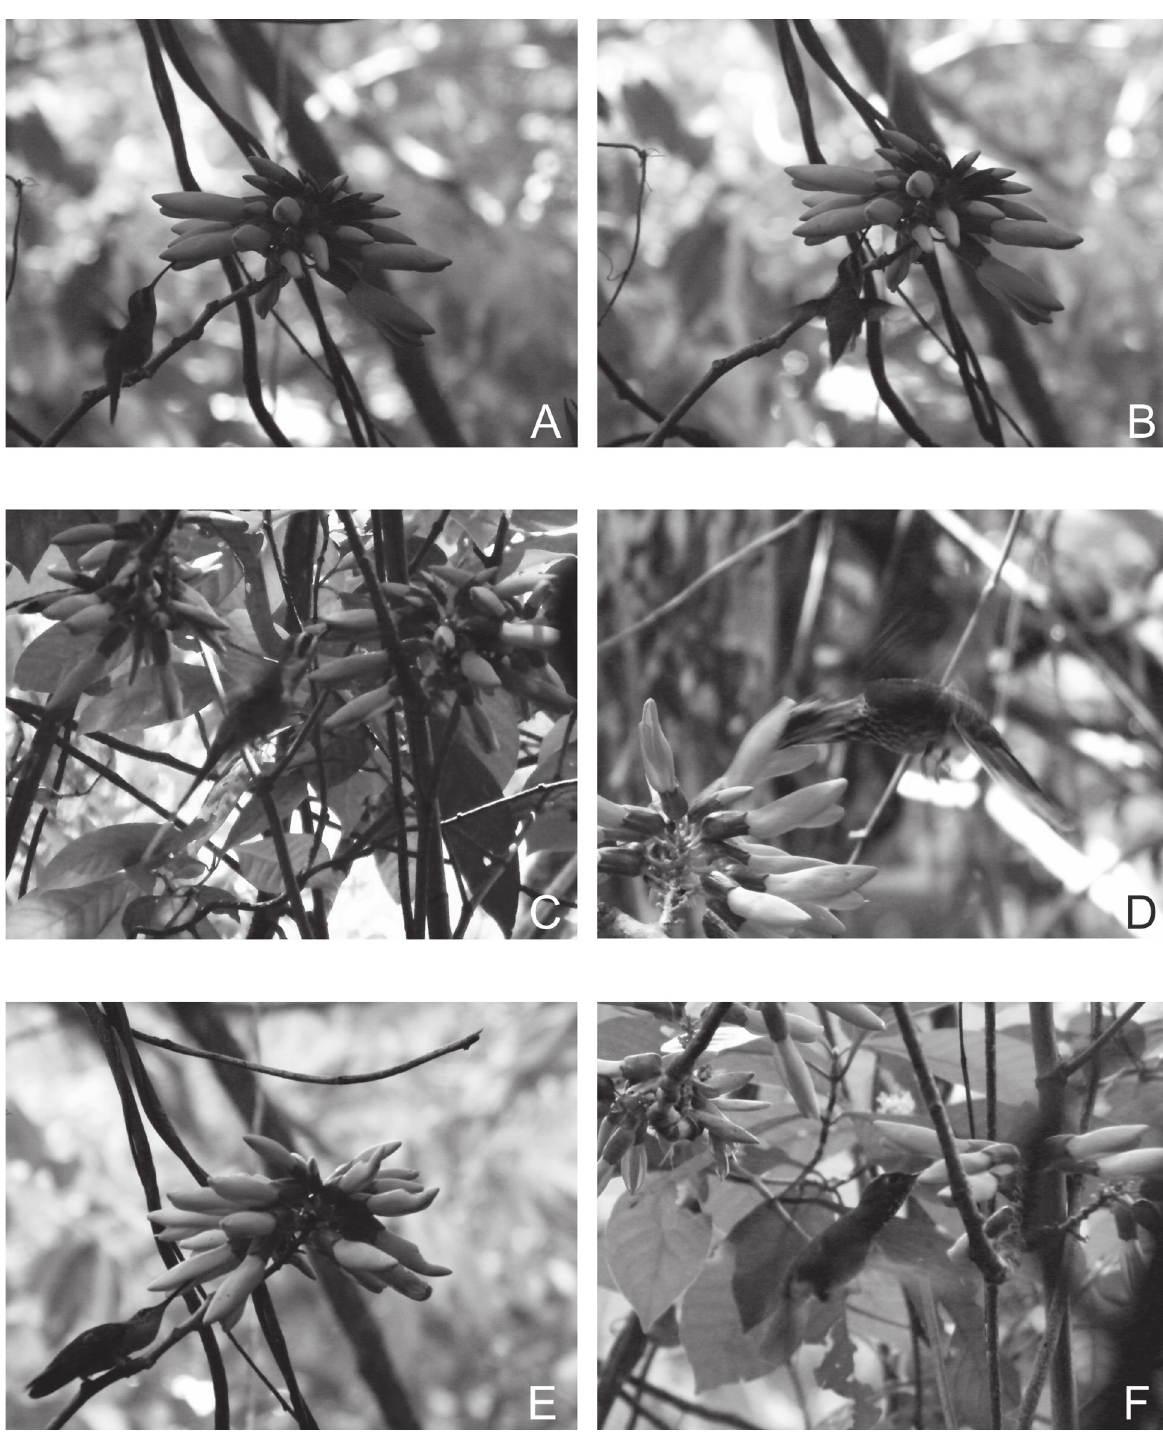
Figure 1 - Flower visitors of 10 individuals of the plant Dahlstedtia pinnata monitored between August 2010 and August 2011, in Pedra Branca State Park, Rio de Janeiro. a) Legitimate visits by Phaethornis ruber ; b) Illegitimate visits by P. ruber ; c) Legitimate visits by P. pretrei ; d) Legitimate visits by Ramphodon naevius ; e) Illegitimate visits during landing by Thalurania glaucopis females; f) Illegitimate visits by Amazilia fimbriata . Photos: Caio